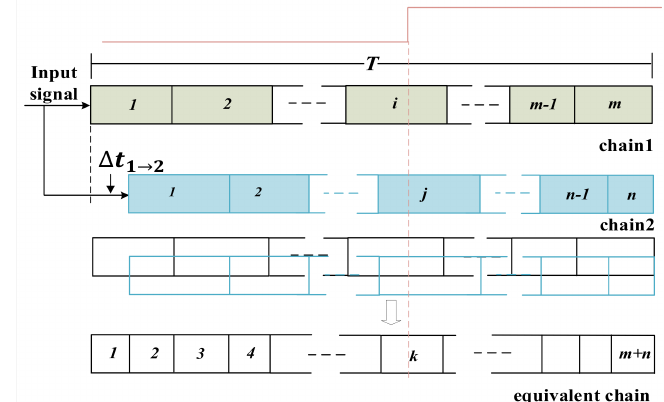
Figure 5. Schematic diagram of cross segmentation with two